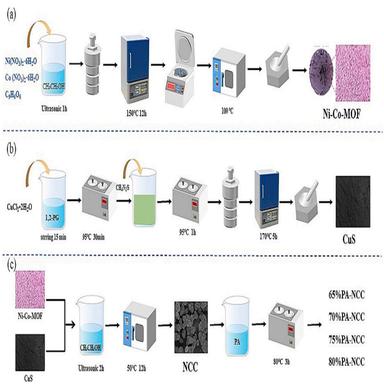
Flow chart of PA-NCC preparation.